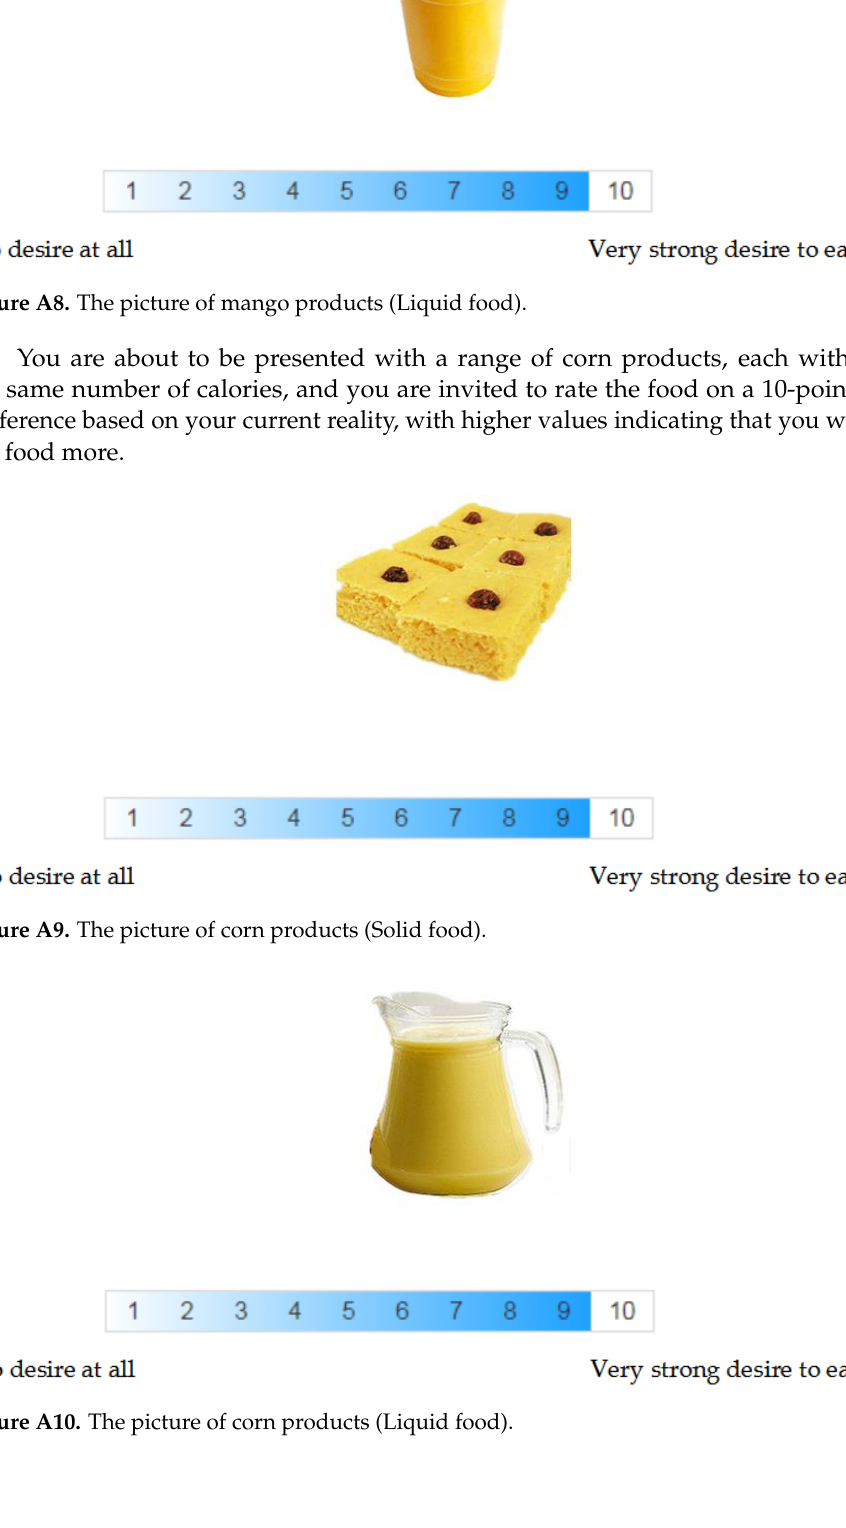
Figure A7. The picture of mango products (Solid food).